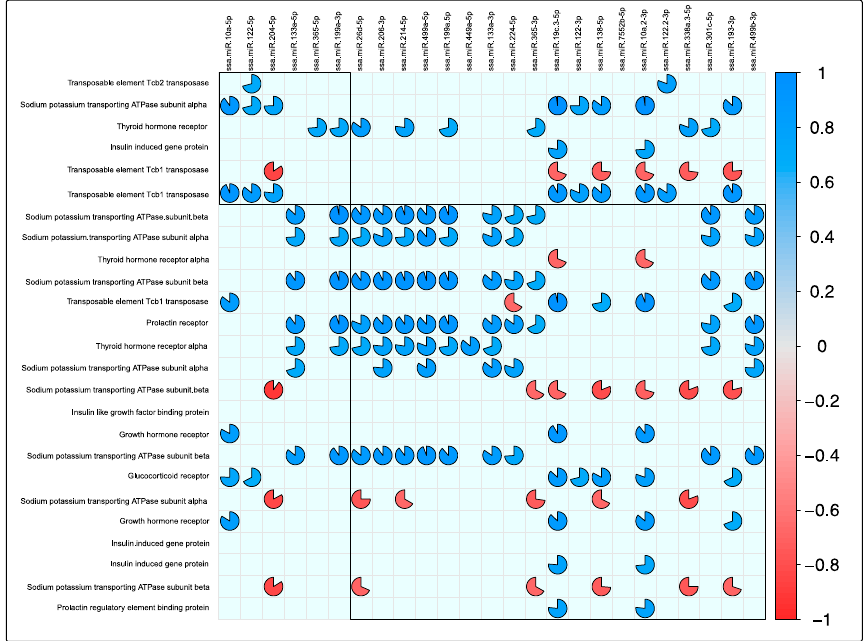
Figure 8. Correlation analysis of expression pairs among smoltification-related genes, TEs, and differential expressed miRNAs. TPM values. Corrplot analyses were conducted on differentially expressed smoltification-related genes, TEs, and differential expressed miRNAs (fold change > |4| and p -value < 0.01) in the combination of all the data, including exposure to the three tissue and GSC and SS conditions. Only Pearson’s correlation values that were significant ( p -value > 0.01) are shown in the plot. Red pies correspond to significant negative correlations, and blue pies correspond to significant positive correlations. The completeness of the pies corresponds to the correlation level, where pies closer to circular shape correspond to values more proximal to |1| in Pearson’s calculation.